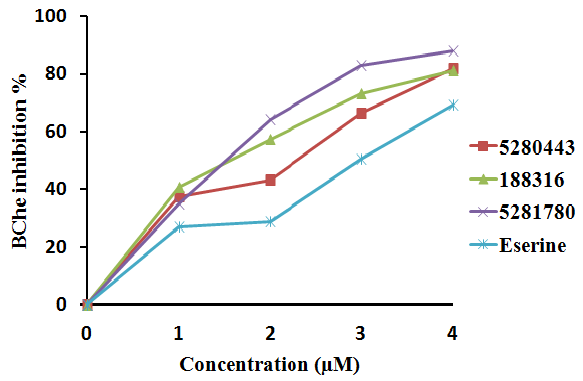
Figure 7. BChE inhibition percentage and inhibitor concentration plot.